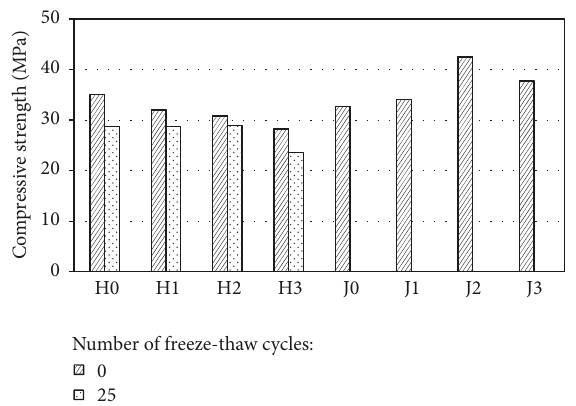
Figure 6: Compressive strength of various types of concrete.